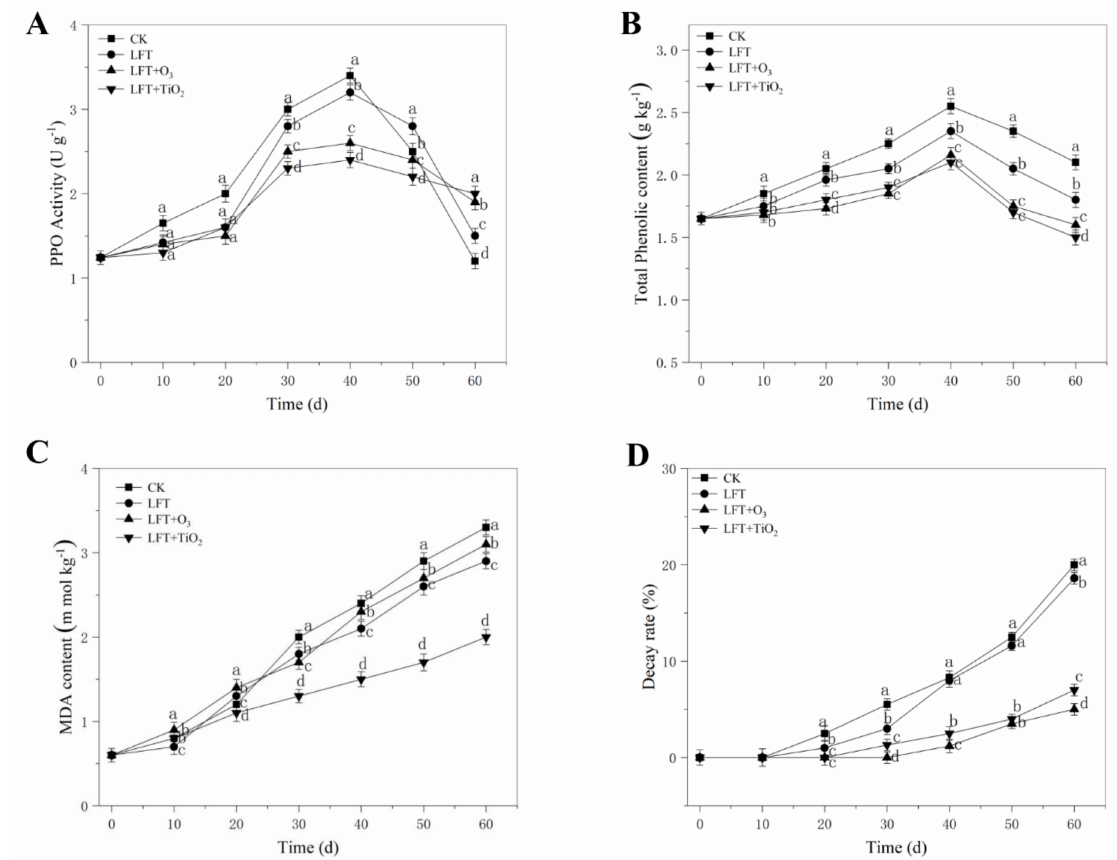
Figure 5. E ff ect of control (CK), LFT, LFT combined with ozone treatment (LFT + O 3 ) and LFT combined with TiO 2 photocatalytic (LFT + TiO 2 ) treatments on the PPO activity, total phenolics content, decay rate, and MDA content of peaches fruit during storage at 0 ◦ C for 60 d. Values are expressed as means ± SD ( n = 10). Di ff erent letters (a–d) indicate significant di ff erences among treatments for each sampling time at p < 0.05. ( A ) PPO activity. ( B ) Total phenolics content. ( C ) Malondialdehyde content. ( D ) Decay